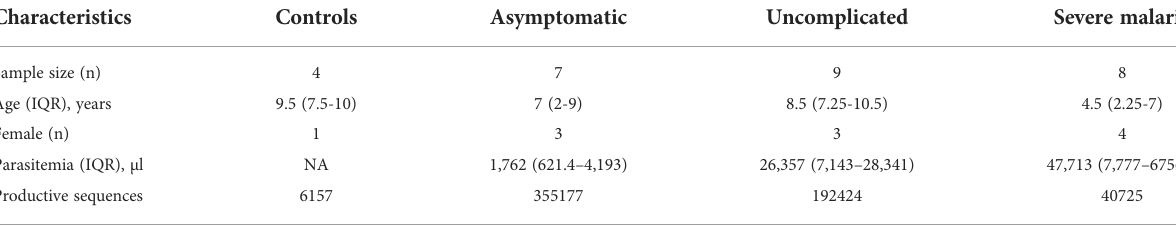
TABLE 1 Characteristics of the study